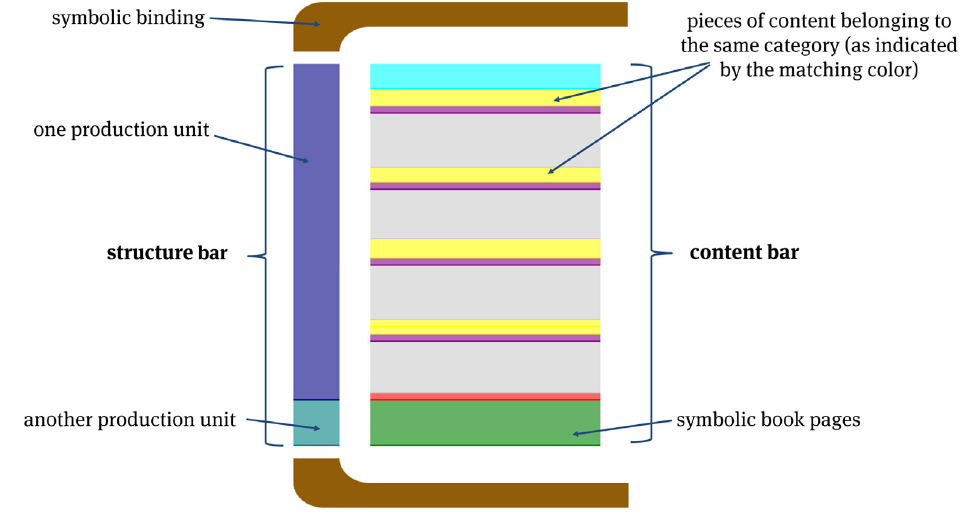
Figure 1. Sample Visualization of a Manuscript in StruViMan10 The visualization has two